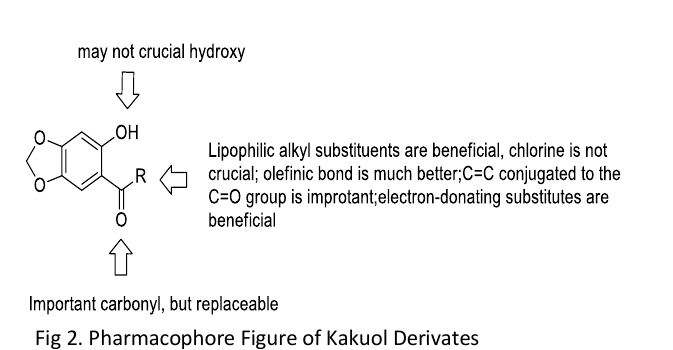
Fig 2. Pharmacophore Figure of Kakuol